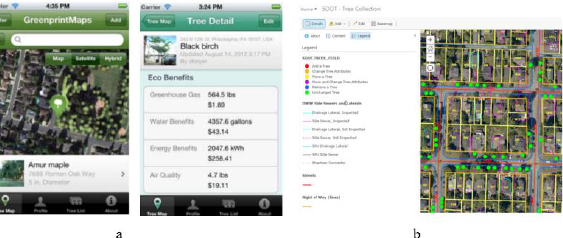
Figure 3. a) The views from OpenTreeMap application, b)